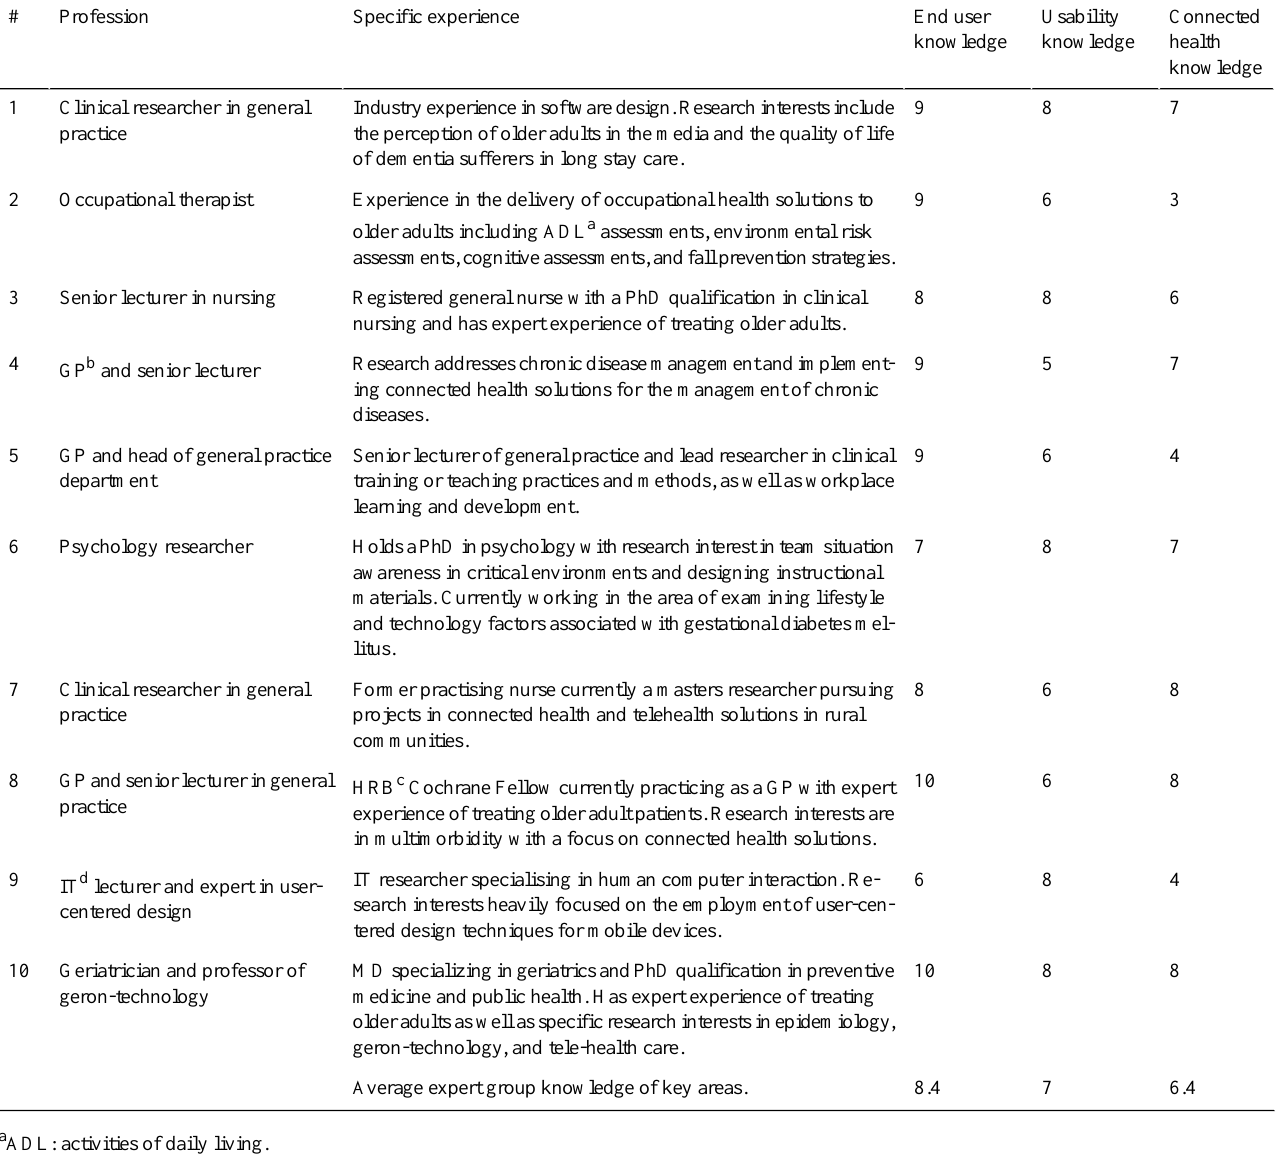
Table 1. Experts involved in use case analysis. Each of the experts was asked to mark out of 10 where they felt their own expertise of usability, the end user, and connected health